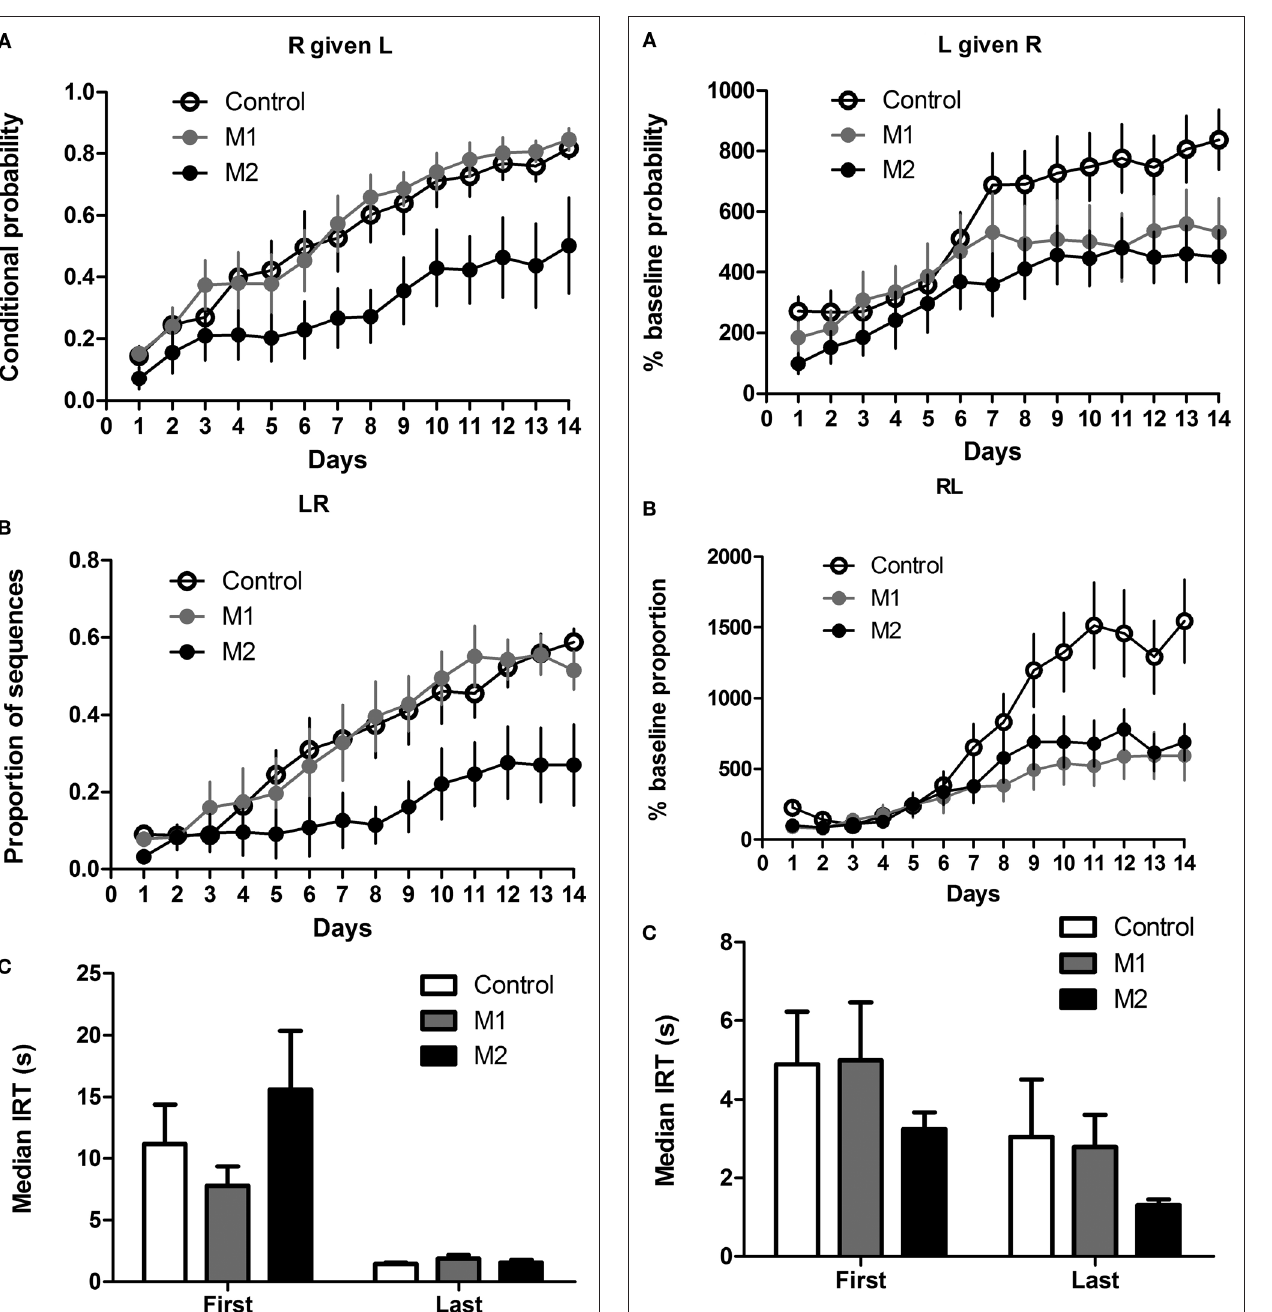
FIgure  | Acquisition of a simple left lever → right lever sequence. (A) Conditional probability of right lever press given left lever press. (B) Proportion of correct sequences. (C) Inter-response-times (IRT) of correct sequences.